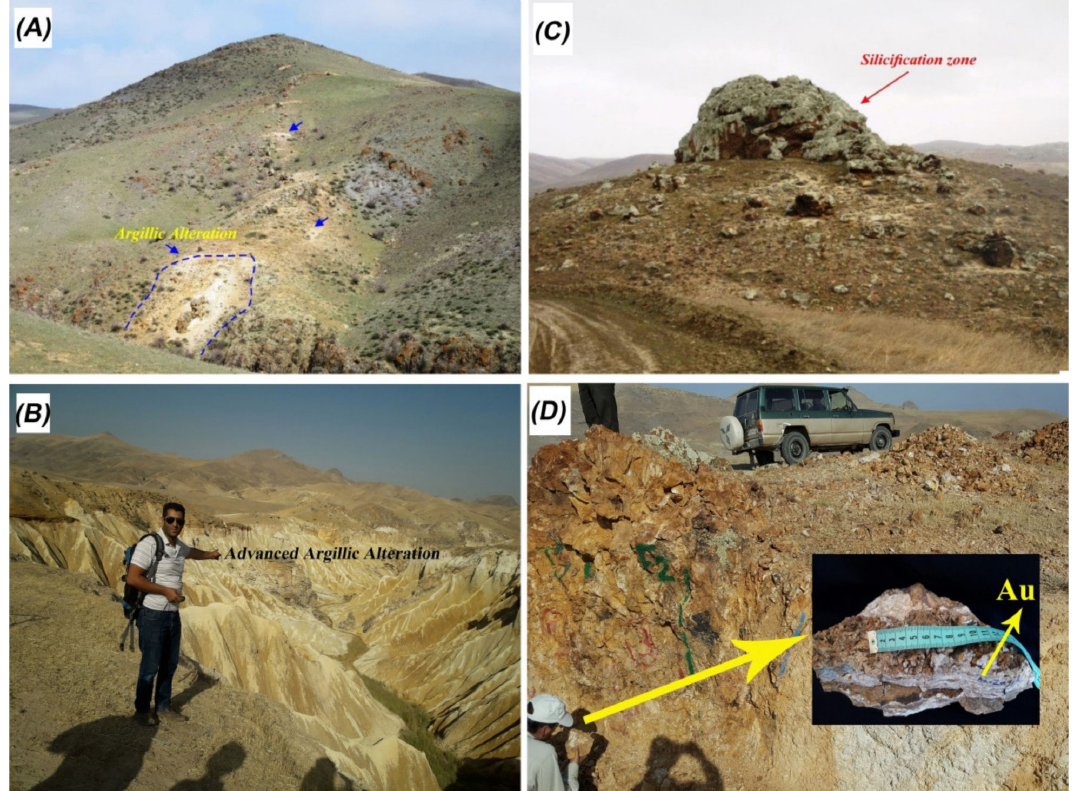
Figure 14. Field photographs of typical hydrothermal alteration zones in the Zailig area. ( A ) View of argillic alteration zone close to the quartz veins; ( B ) Regional view of advanced argillic alteration zone; ( C ) View of silicification alteration zone with iron oxides, ( D ) Close view of argillic-silica alteration and a sample of crustiform and colloform banded chalcedonic gold-quartz vein.